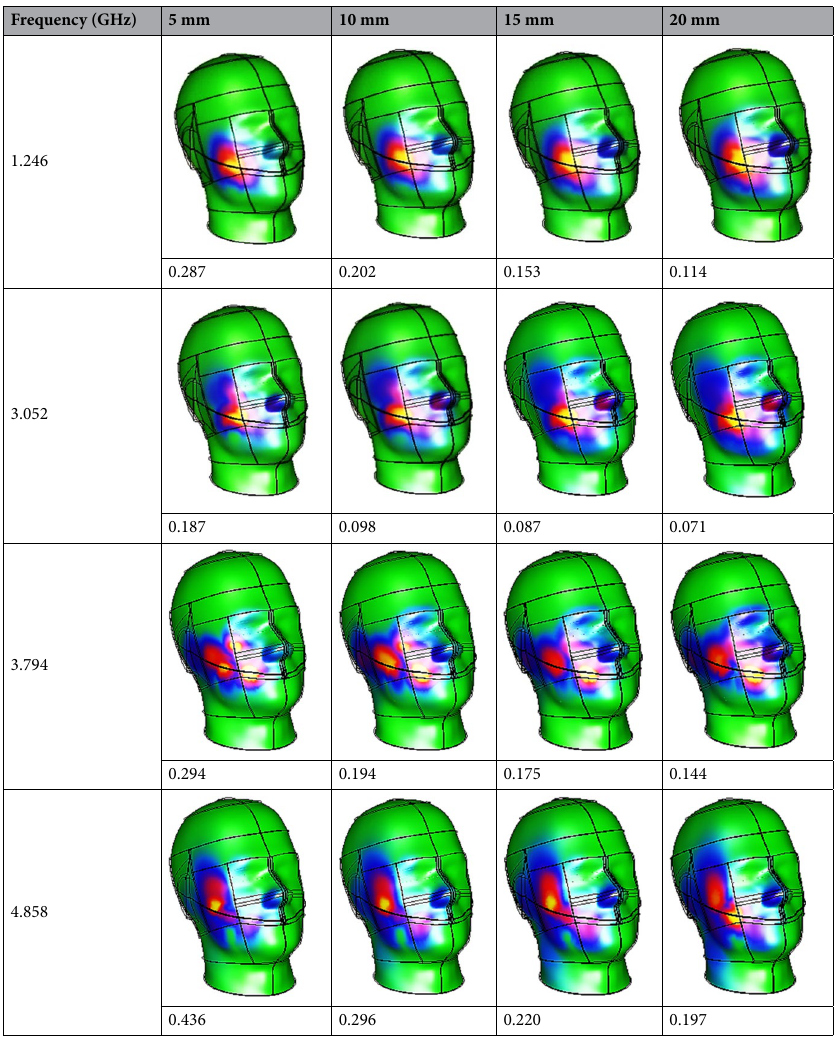
Table 11. SAR values of 1 g of tissue volume for various mobile phone distance from human